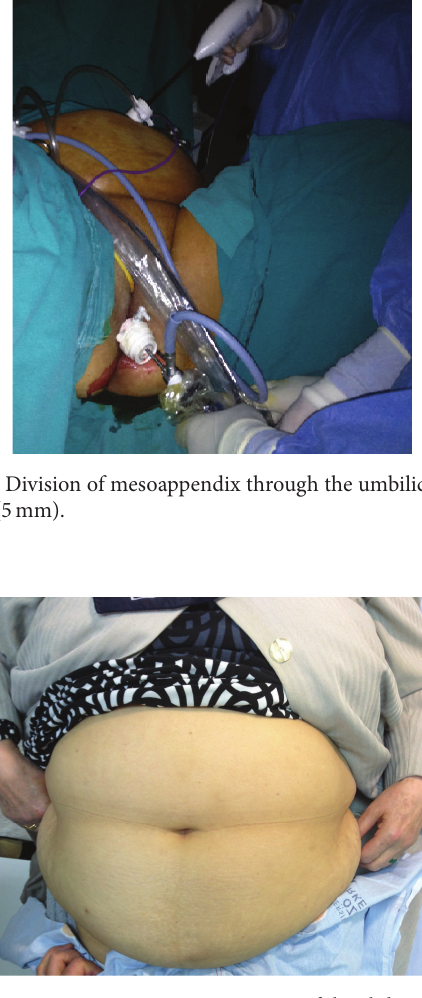
Figure 4: Postoperative appearance of the